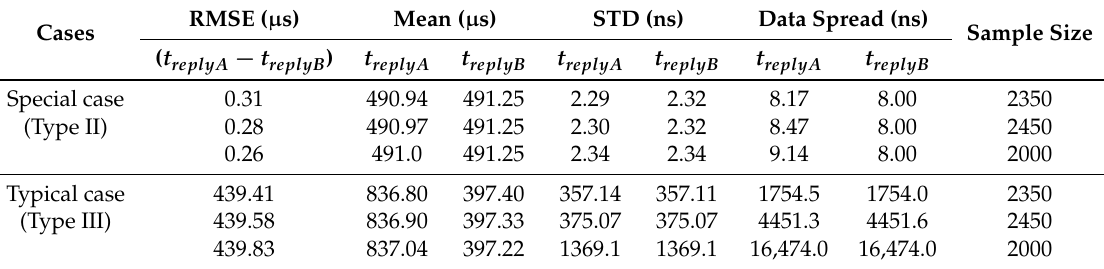
Table 4. Sample reply time drawn randomly from each of the three categories (LOS, close LOS, and multipath scenarios). Note: RMSE, Root Mean Square